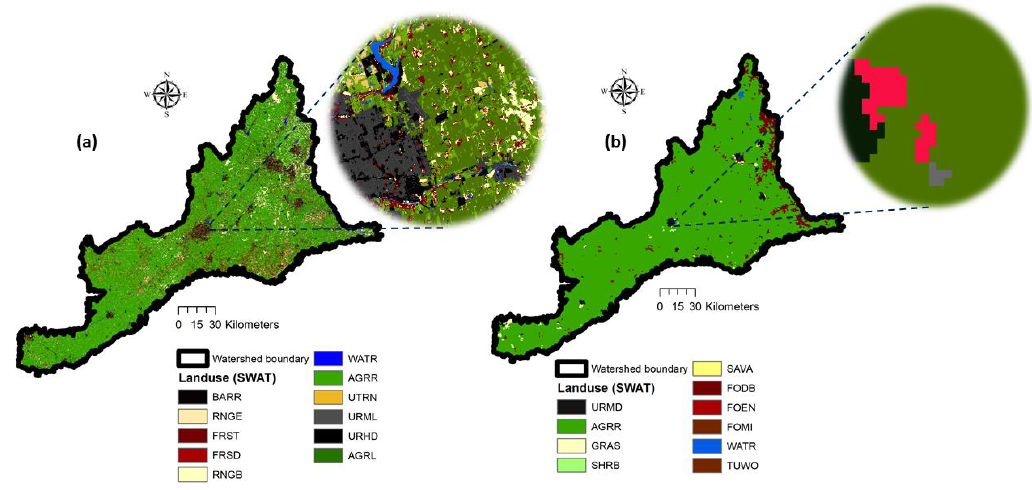
Figure 2. Two land use coverage maps of Northern Lake Erie basin: ( a ) Southern Ontario Land Resource Information System (SOLRIS) with 30 m resolution. ( b ) Global land cover classification (GLCC) with 1 km resolution.